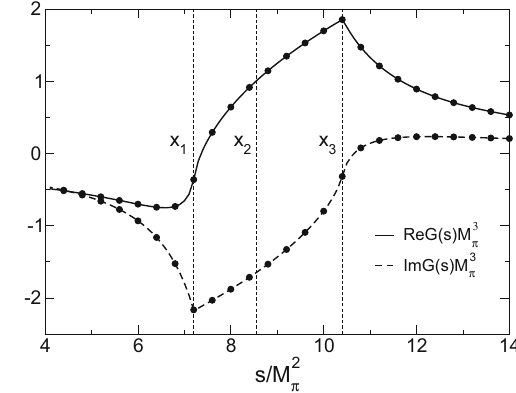
Fig. 4 Analyticalandnumericalresultsforthefunction G ( s ) inEq.10. The solid and dashed lines denote the real and imaginary part of the analytical result [42], the filled circles denote the result from the Gauss– Legendre integration along the polygonal line x 1 B 1 C 1 x 3 in Fig.